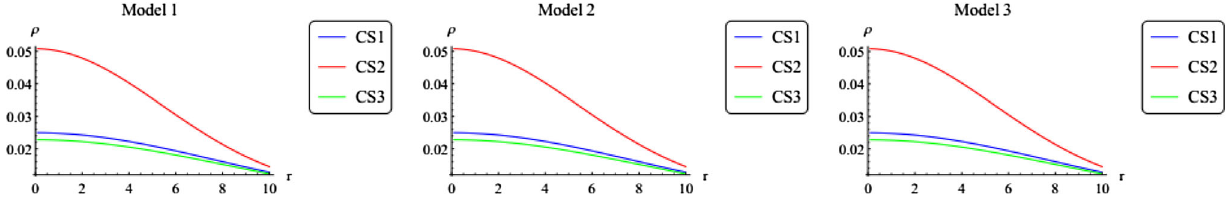
Fig. 1 Variation of density profile for charged stars, Vela X-1, SAX J 1808.4-3658, and 4U 1820-30, under different viable f ( G ) models